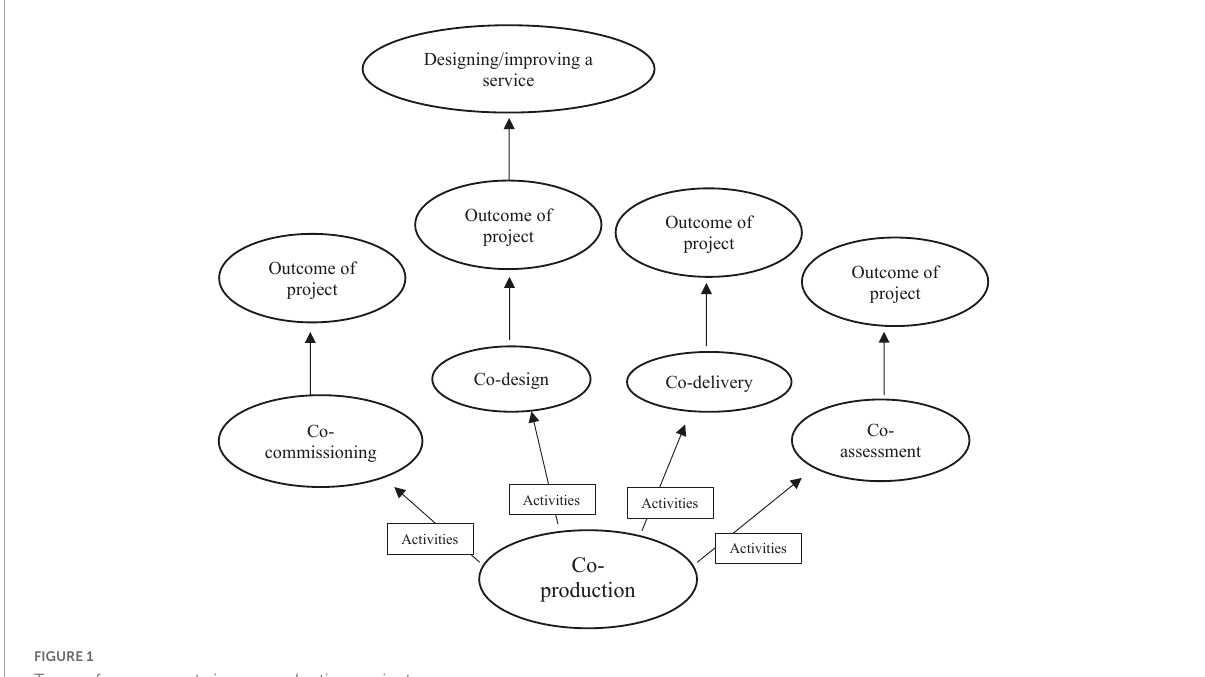
FIGURE1 Types of co-concepts in co-production